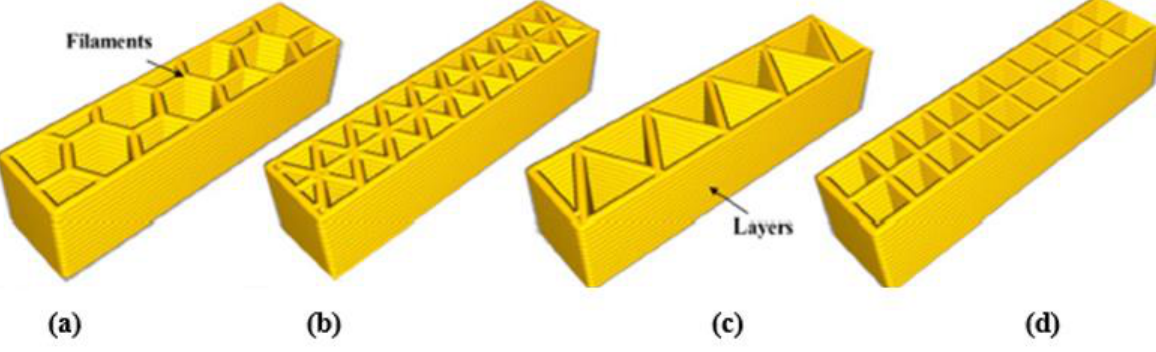
Figure 2. The different 3DPC cavity wall configurations studied by Wang et al. [24]: ( a ) cellular topology; ( b ) triangular topology; ( c ) truss topology; ( d ) lattice topology.